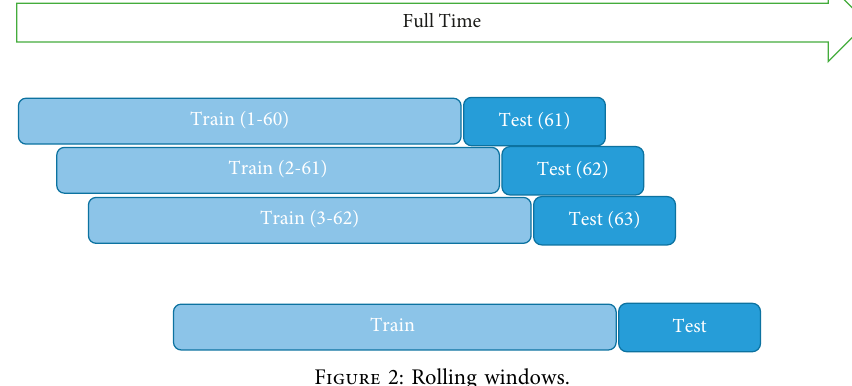
Figure 2: Rolling windows.